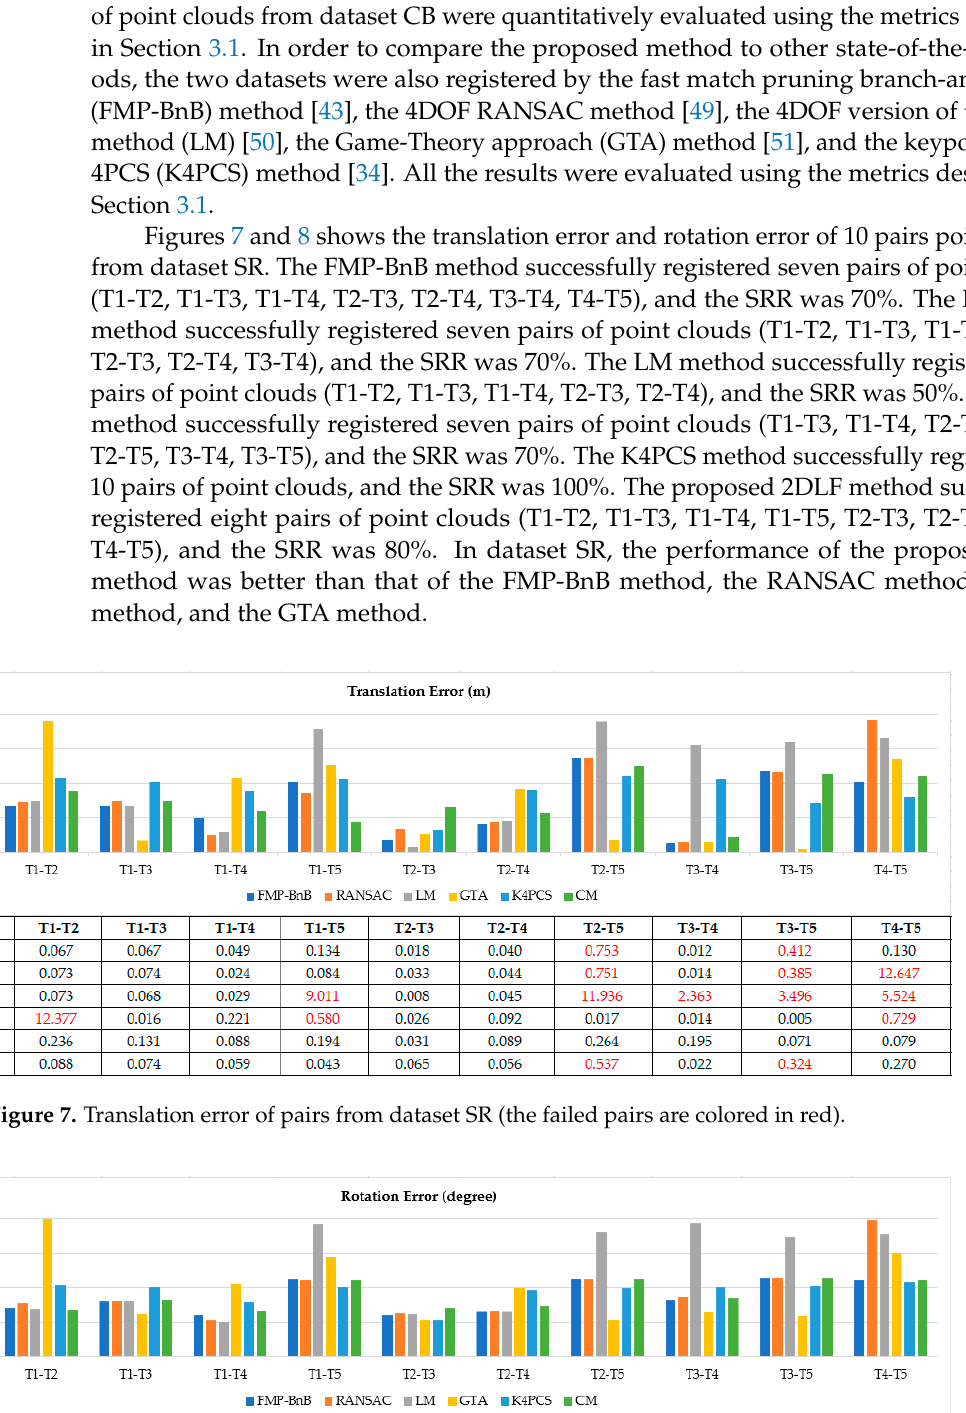
Figure 6. The registration results of 19 pairs of point clouds in dataset CB. The first column is the point clouds before registration, the second column is the point clouds after registration using the proposed method, and the third column is the horizontal section view of the point clouds after registration. The brown points are target points and the blue points are source points.